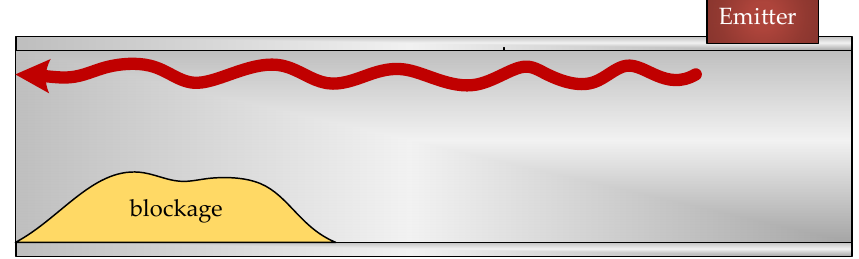
Figure 7. Blockage detection. The guide wave does not collide with the blockage due to its location.